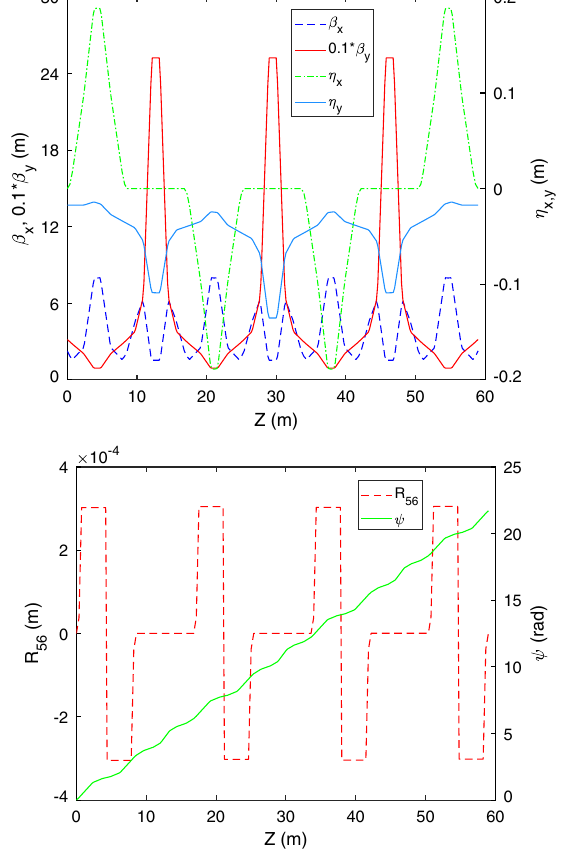
FIG. 3. Upper: Courant-Snyder parameters β x , β y , and dispersion functions along the delay system. Bottom: R 56 and betatron phase advance in the horizontal plane along the delay system.